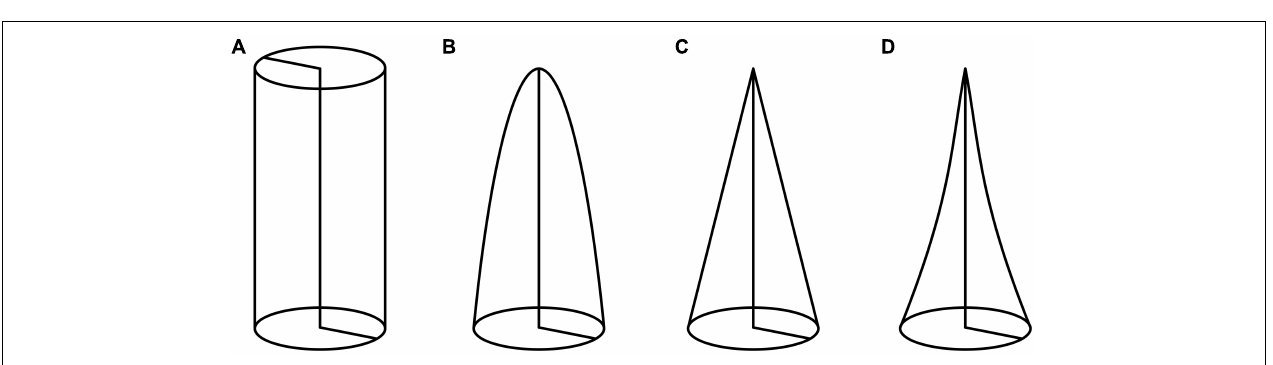
FIGURE 2 | Tapering modes α of various slender structures: (A) α = 0 represents a circular cylinder, (B) α = 0.5 a second order paraboloid of revolution, (C) α = 1 a circular cone, and (D) α = 1.5 a hyperboloid of